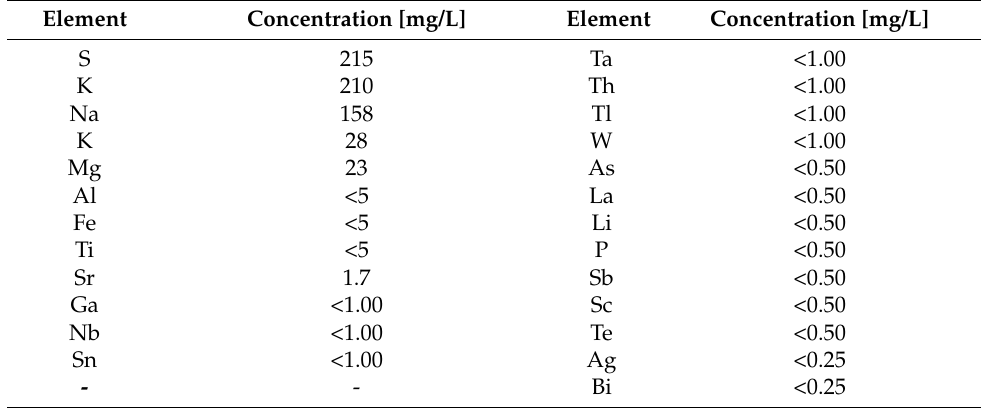
Table 2. ICP test for characterization of industrial